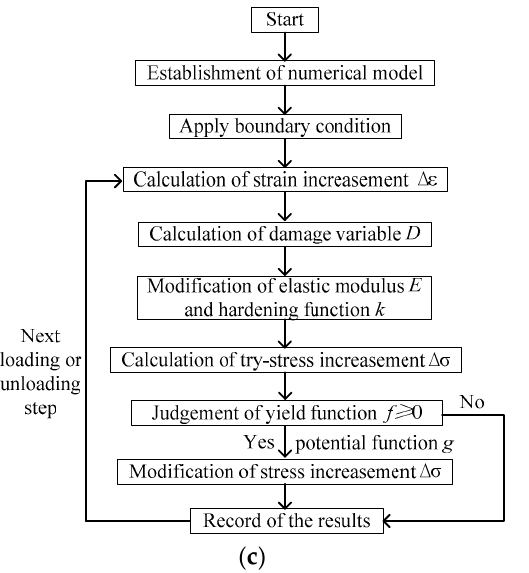
Figure 3. Calculation programs of three representative models: ( a ) the empirical damage model; ( b ) the statistical damage model; and ( c ) the elastoplastic damage model.